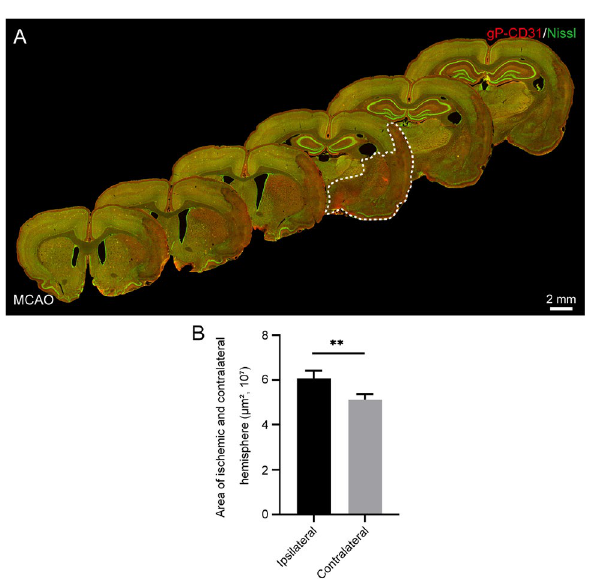
Figure 2. Regional alteration of the rat brain with ischemia/reperfusion. ( A ) Representative montage views from every 12th coronal sections of brain immunofluorescently stained with goat polyclonal anti-CD31 (gP- CD31) and Nissl showing the regional alteration induced by ischemia/reperfusion at vascular and cellular level. ( B ) Quantitative analysis of the areas of ischemic hemisphere and its contralateral hemisphere (n = 4 rats, ** P <